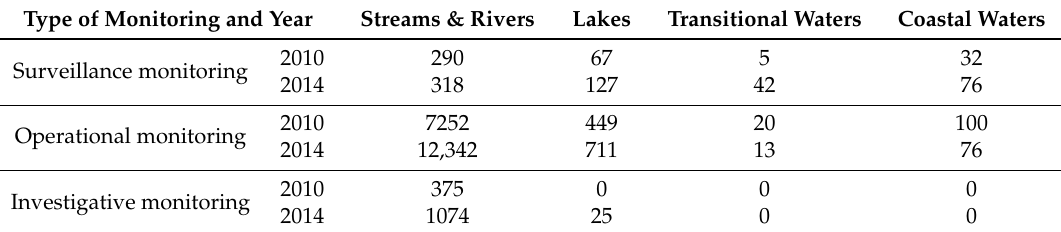
Table 1. Number of monitoring stations for different monitoring types and categories of surface waters in Germany. Data source: Federal Environment Agency (Umweltbundesamt) data from the Working Group on Water Issues of the Federal States and the Federal Government (LAWA). Data origin: Reporting portal WasserBLIcK/BfG as of 22 March 2010 after Mohaupt et al. , 2012 [9] and reporting portal WasserBLIcK/BfG as of November